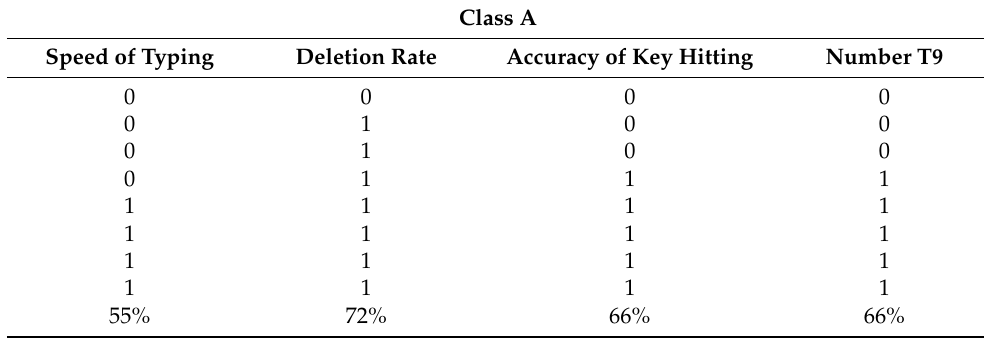
Table 7. Example of weight calculation for parameter A.